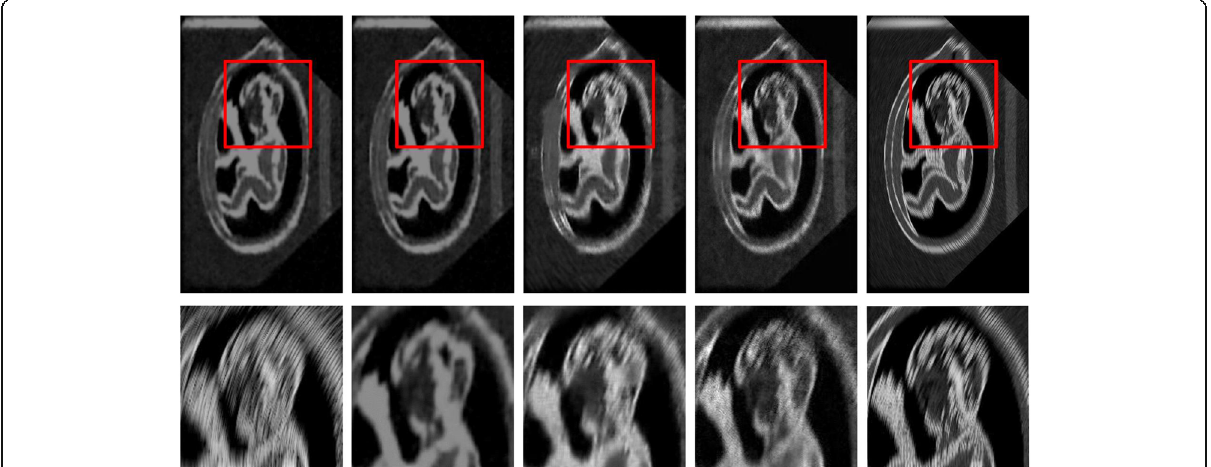
Fig. 5 Result examples of simulated fetus images. On the first line from left to right are low-quality image, encoder-decoder result, U-Net result, SSC U-Net result, and high-quality image correspondingly. The second line shows the image in the corresponding red box in the first line